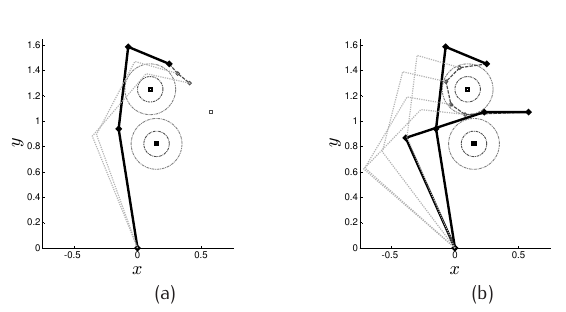
Figure 7. A 3-DOF planar robot moving around and in between two obstacles using (a) the APF, and (b) our proposed algorithm.